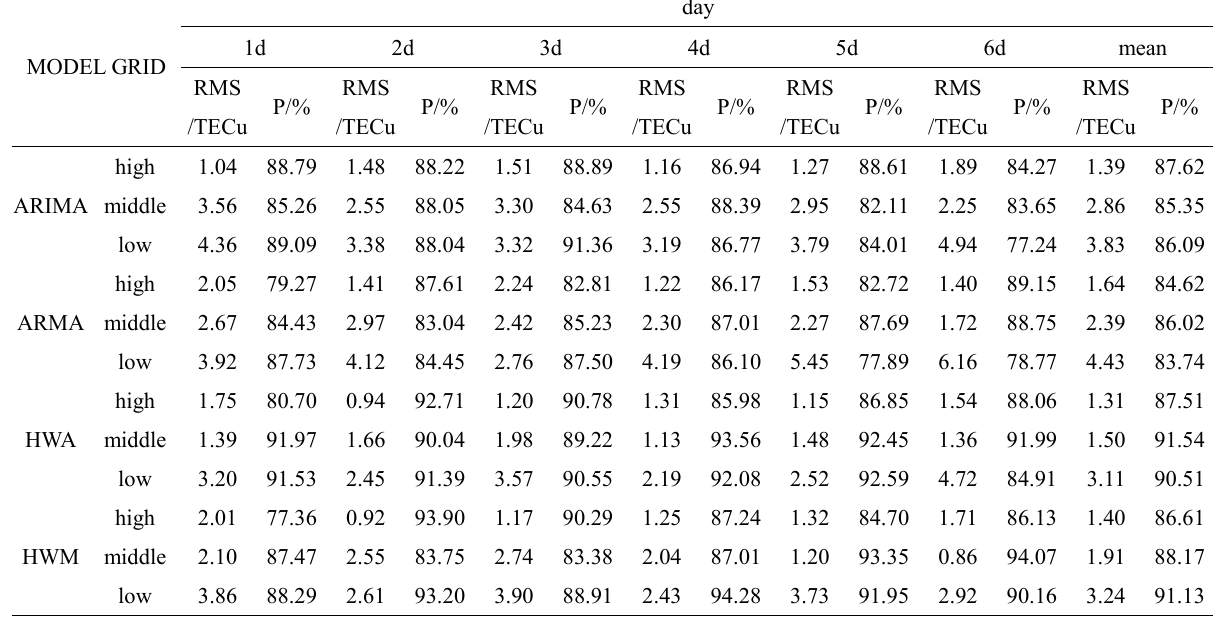
Table 3. RMS and relative accuracy in ionospheric quiet period